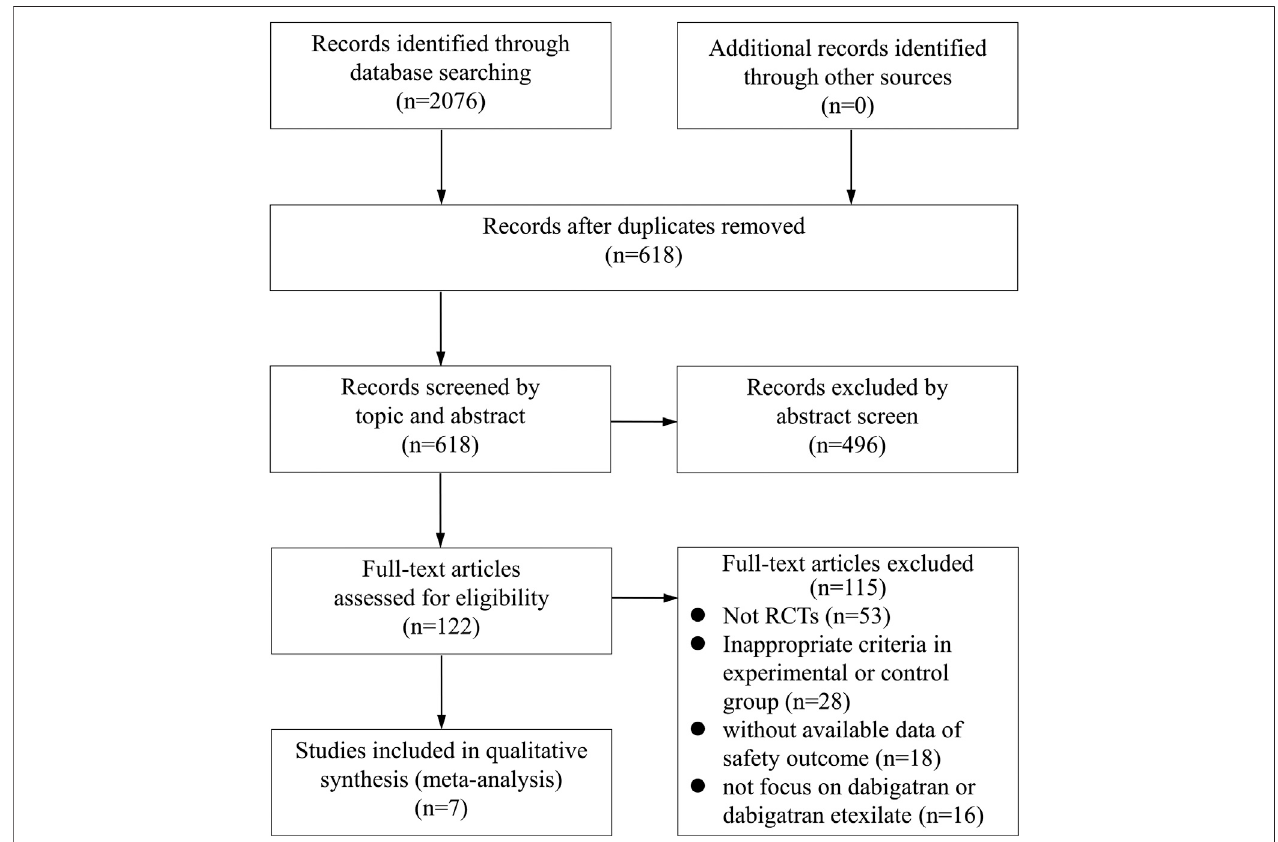
FIGURE 1 | Process of selection of studies for